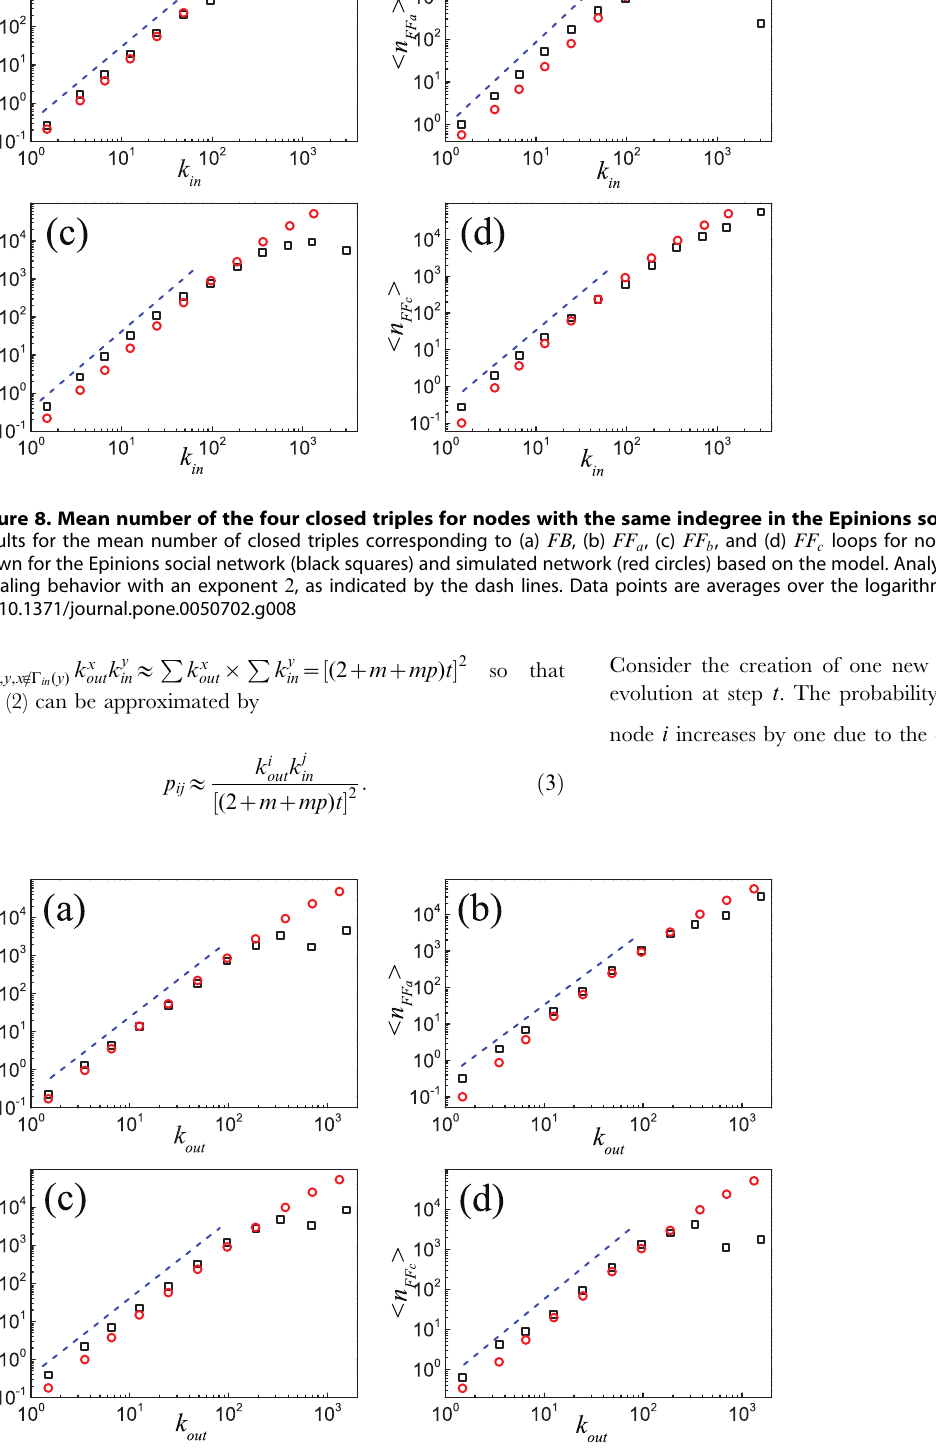
Figure 9. Mean number of the four closed triples for nodes with the same outdegree in the Epinions social network and the model. Results for the mean number of closed triples corresponding to (a) FB , (b) FF a , (c) FF b , and (d) FF c loops for nodes with the same outdegree are shown for the Epinions social network (black squares) and simulated network (red circles) based on the model. Analytic treatment (see Eq. (28)) gives a scaling behavior with an exponent 2 , as indicated by the dash lines. Data points are averages over the logarithmic bins of the outdegree k out .